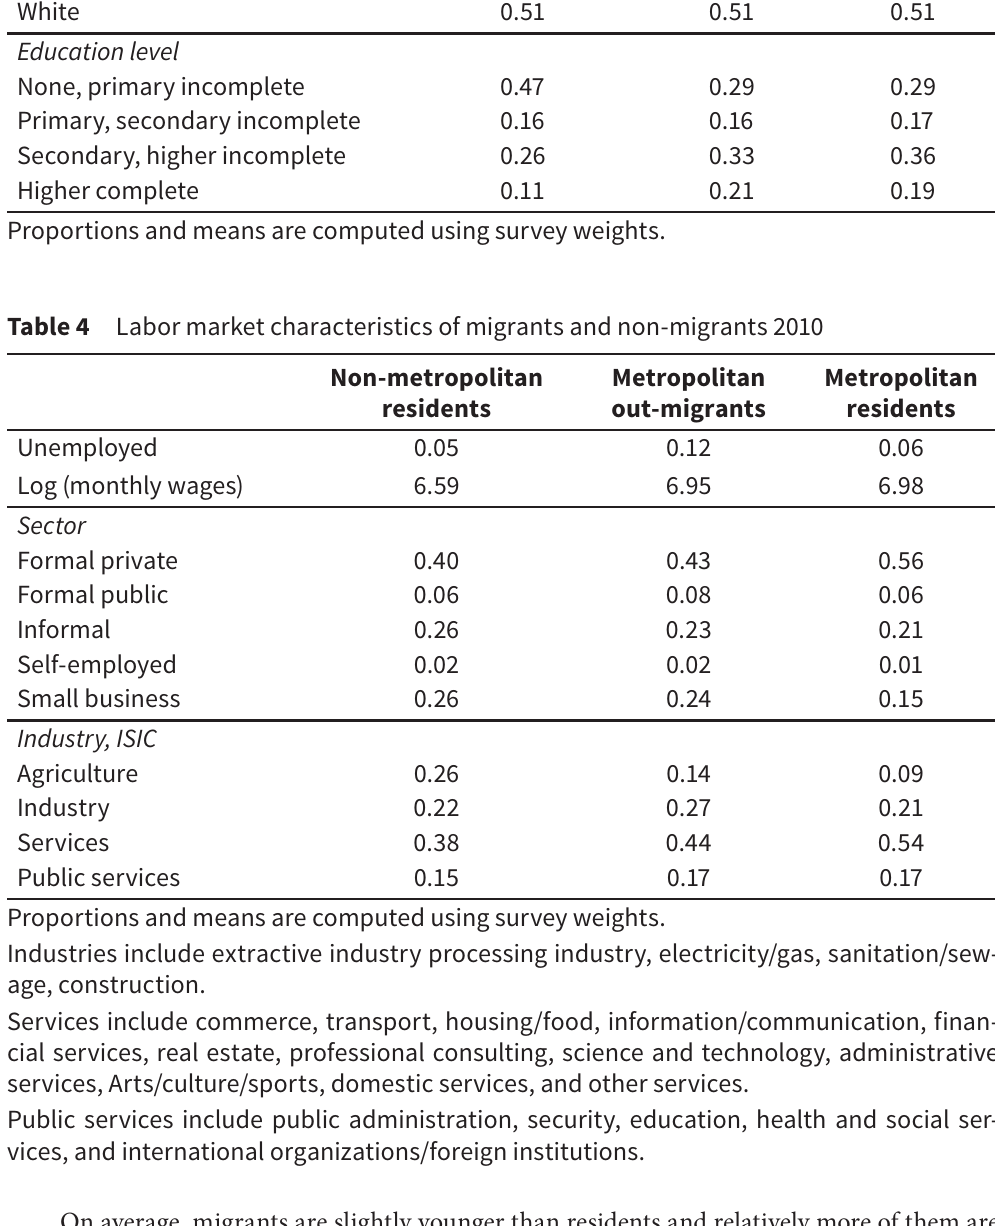
Table 4 documents the labor market characteristics of out-migrants and residents. Around 12% of workers who left the metropolitan cities for non-metropolitan destinations